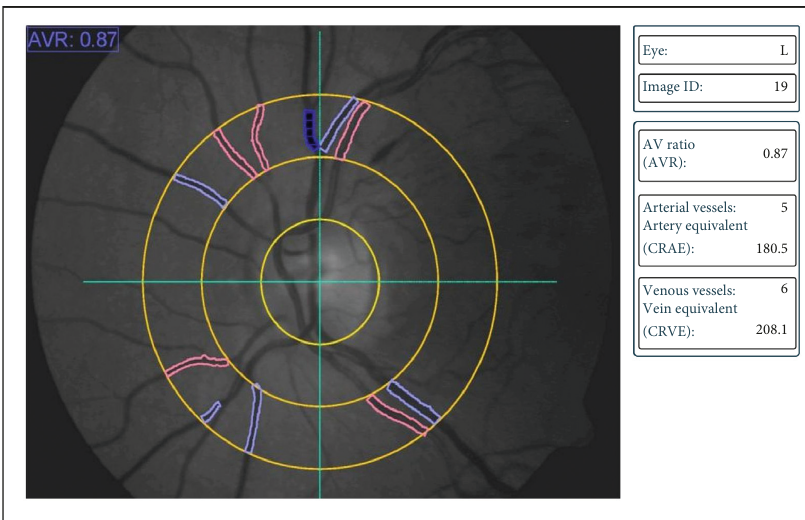
Figure 2: Static vessel analysis of patient #3 with macular edema secondary to branch retinal vein occlusion (BRVO). After fundus photograph was taken, arterial and venous vessels were manually selected and central retinal artery equivalent, central retinal vein equivalent, and arteriovenous ratio were